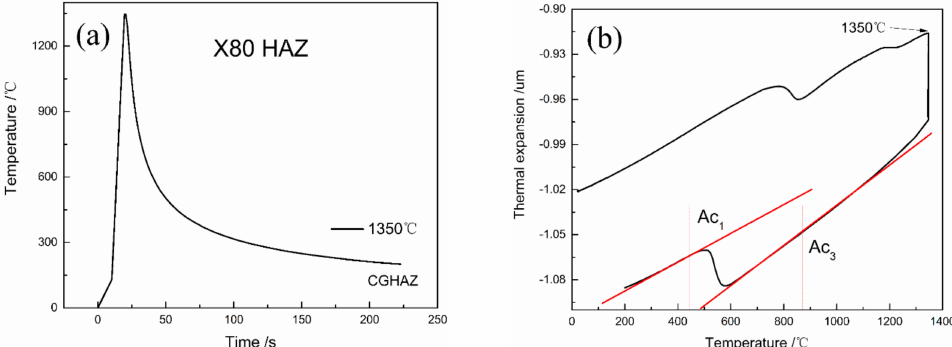
Figure 1. Schematic of the ( a ) welding thermal cycles and ( b ) transformation